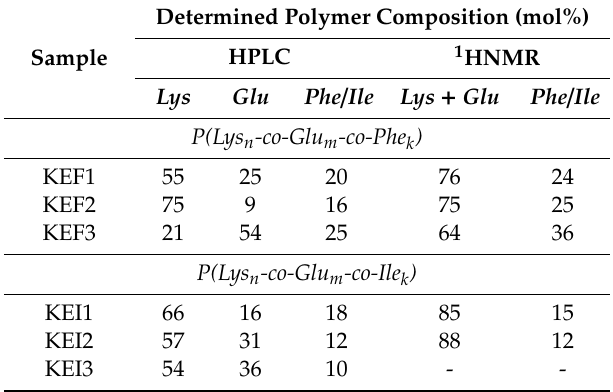
Table 2. Composition of amphiphilic amino acid